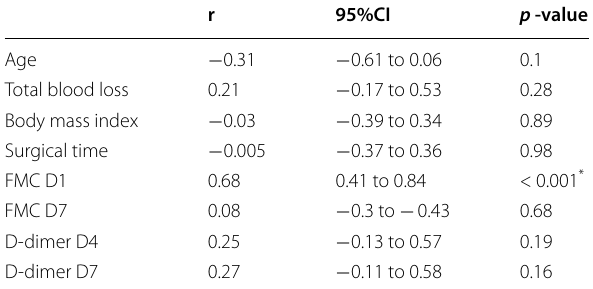
FMC Fibrin monomer complex, CI Confidence